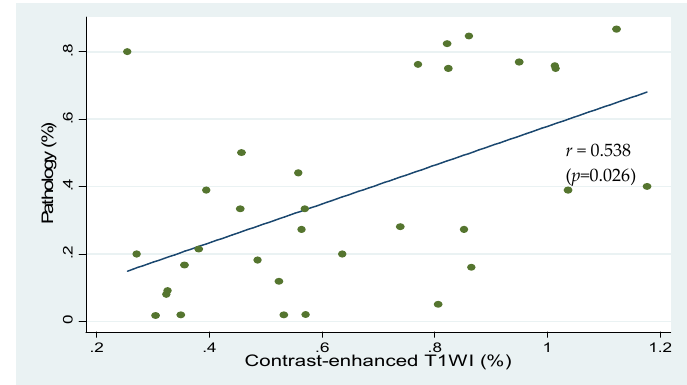
Figure A1. Performance and validation curves for all three architectures of the trained CNN models (VGG11, VGG16 and Resnet34) on MRI. The prediction (IoU) score of CNN models in reading the uterus on contrast-enhanced T1w ( A ) and T2w ( B ). The prediction (IoU) of CNN models in reading endometrium on contrast-enhanced T1w ( C ) and T2w ( D ).